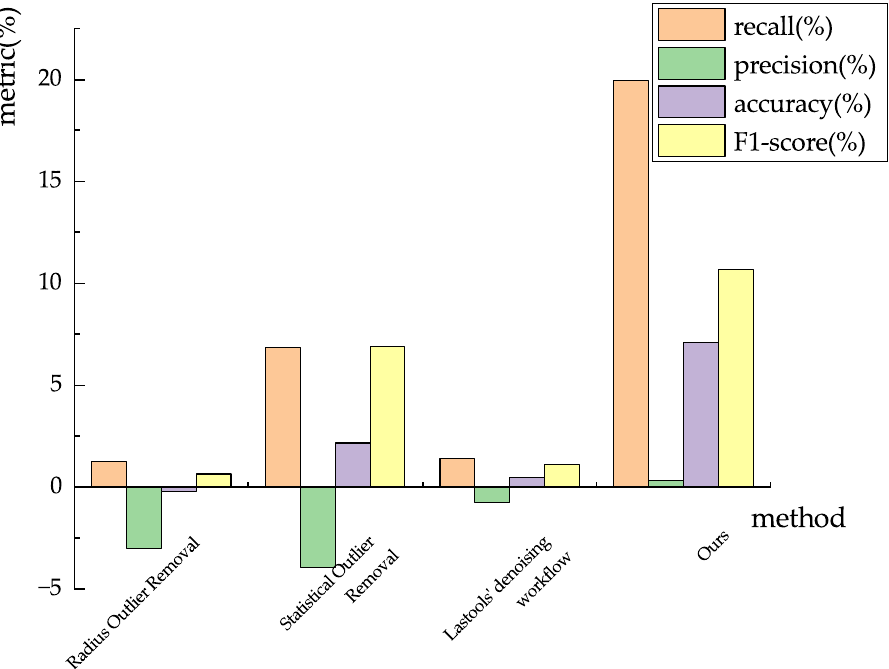
Figure 13. Visualization of the evaluation metrics improvement after multiple